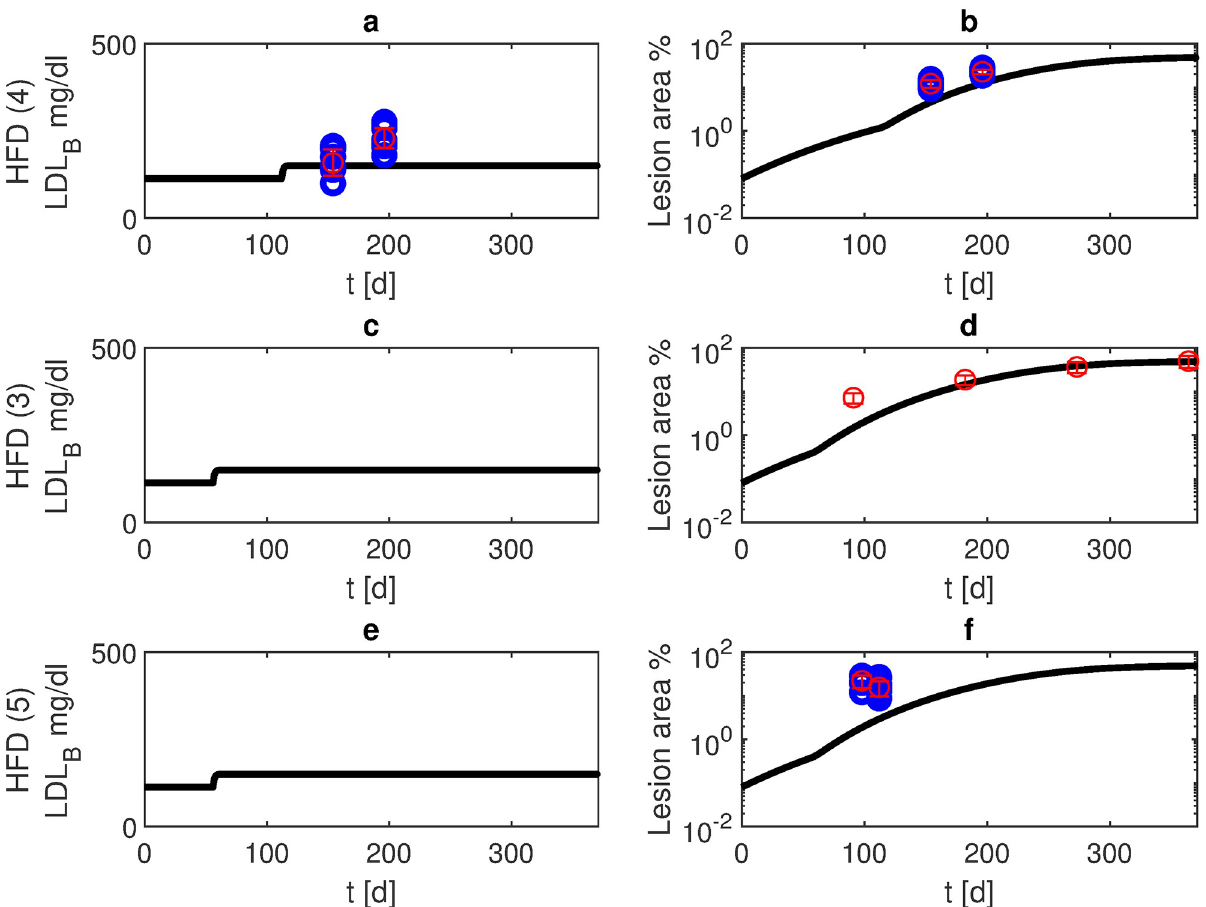
Fig 6. High fat diet. We present model simulations and data of APOE -/- mice at high fat diet (blue: data points, red: mean and standard deviation for scenarios 4 (panels a, b, own experiments), 3 (panels c, d, data from [21]), and 5 (panels e, f, data from [22]). Black curves represent model simulations of LDL-C in blood (panels a, c, e) and lesion area (panels b, d, f). In scenario 4, high fat diet started at the age of 16 weeks while in scenarios 3 and 5 it started at the age of eight weeks.